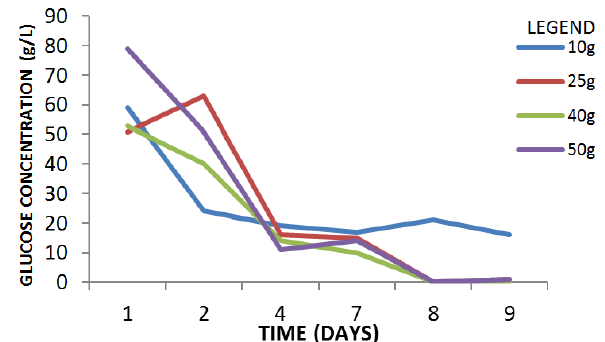
Fig. 3. Residual glucose in the fermentation at different substrate